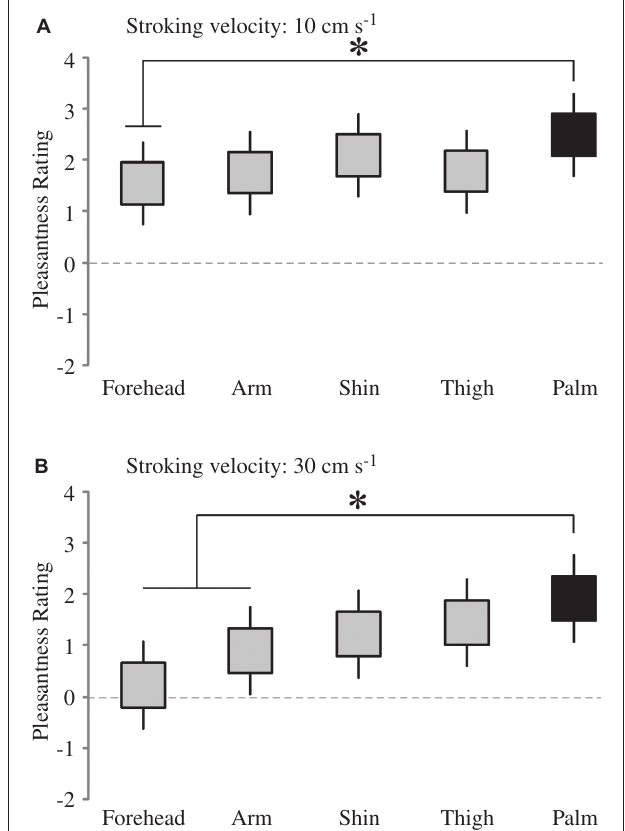
FIGURE 3 | The effect of skin site for pleasantness ratings at higher stroking velocities. There was a significant main effect of skin site at (A) 10 cm s − 1 and (B) 30 cm s − 1 stroking velocities; for comparison of different skin sites at these separate velocities, the other skin sites were compared to the palm (* indicates significant differences, p < 0.05 to the palm ratings). The ratings scale was from − 10 to +10. The upper and lower edges of the boxes relate to the ± 1 S.E.M. around the mean, and the lines are the upper and lower bound 95% confidence intervals.